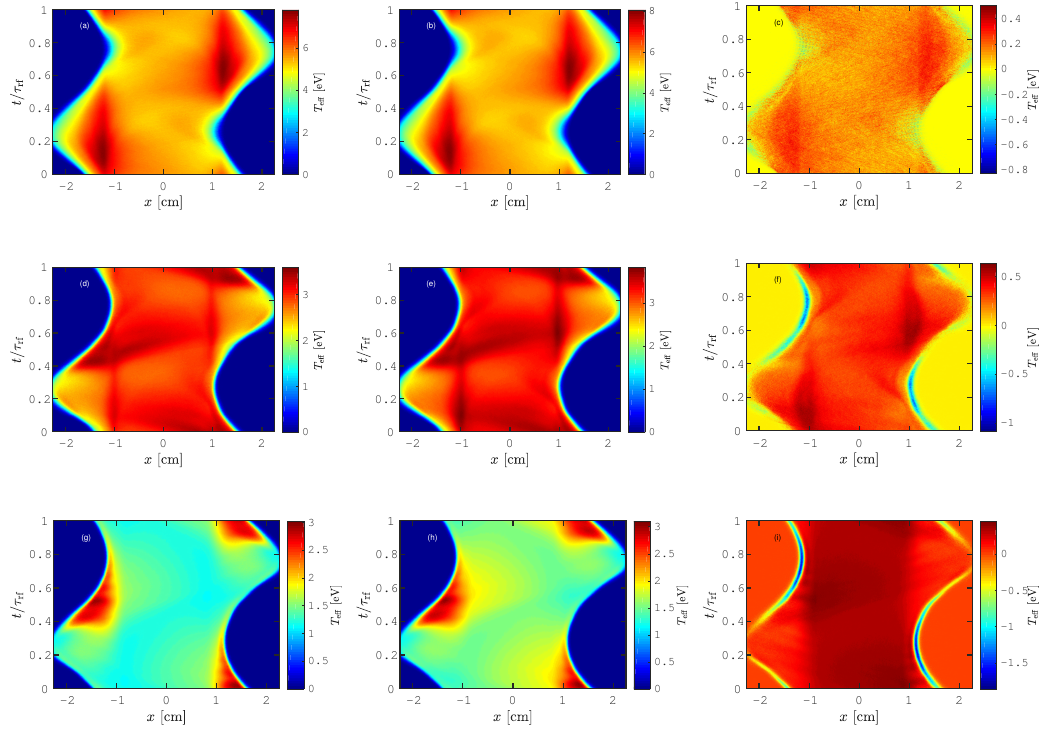
Figure 5. The spatio-temporal behavior of the effective electron temperature for a parallel plate capacitively-coupled oxygen discharge at 10 mTorr for ( a ) γ see ( E ) and ( b ) γ see = 0.0, ( c ) the difference between γ see = 0.0 and γ see ( E ) , at 25 mTorr, for ( d ) γ see ( E ) , and ( e ) γ see = 0.0, ( f ) the difference between γ see = 0.0 and γ see ( E ) , at 50 mTorr for, ( g ) γ see ( E ) and ( h ) γ see = 0.0, and ( i ) the difference between γ see = 0.0 and γ see ( E ) with a surface quenching coefficient for the singlet metastable molecule O 2 ( a 1 ∆ g ) as γ wqa = 0.0001, r = 0.0, and a gap separation of 4.5 cm driven by a 222 V voltage source at a driving frequency of 13.56